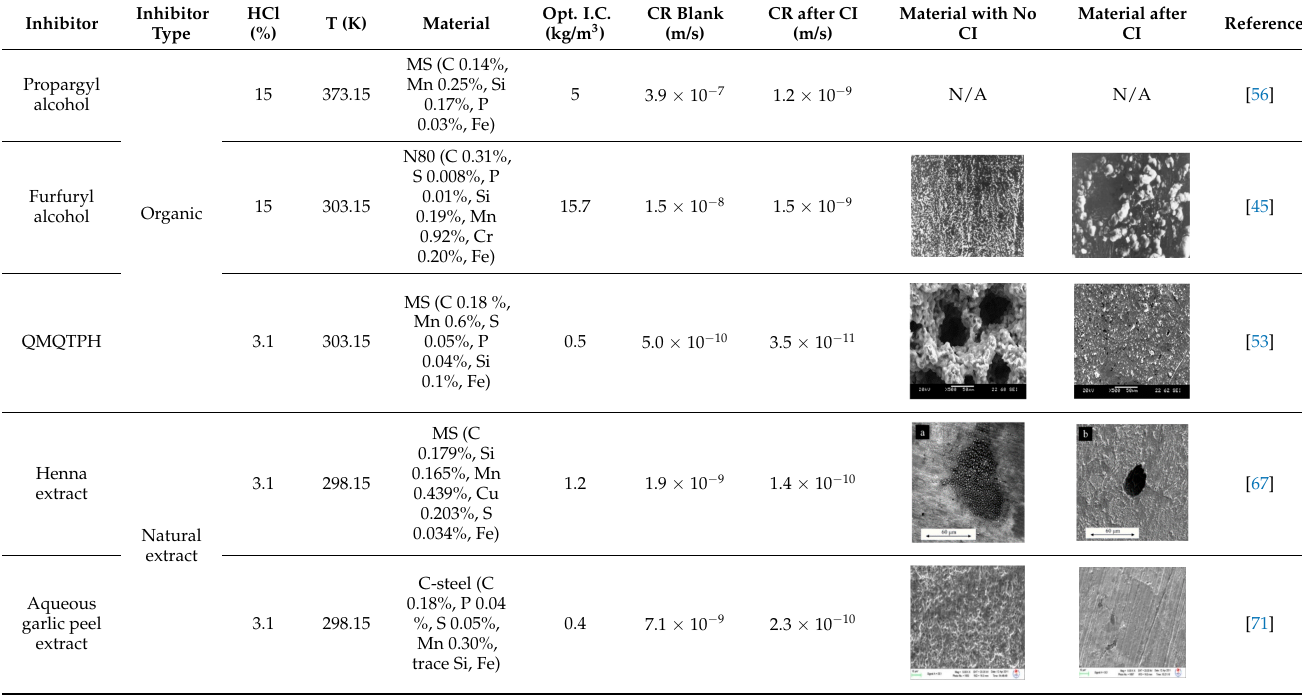
Table 3. Corrosion rates (CR) of different corrosion inhibitors (CI) tested at various inhibitor concentrations (IC), HCl concentrations on carbon steel materials.